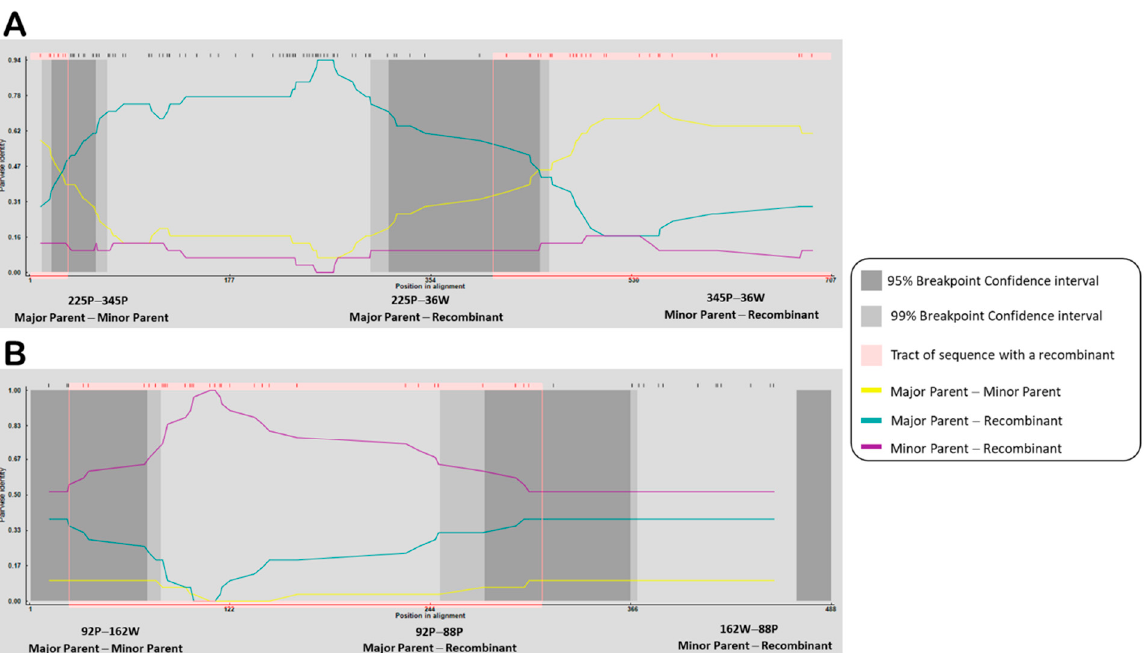
Figure 4. Results of the RDP recombination analysis for the ( A ) P0 gene and ( B ) P3 gene. Lines indicate the percentage of similarity per alignment.